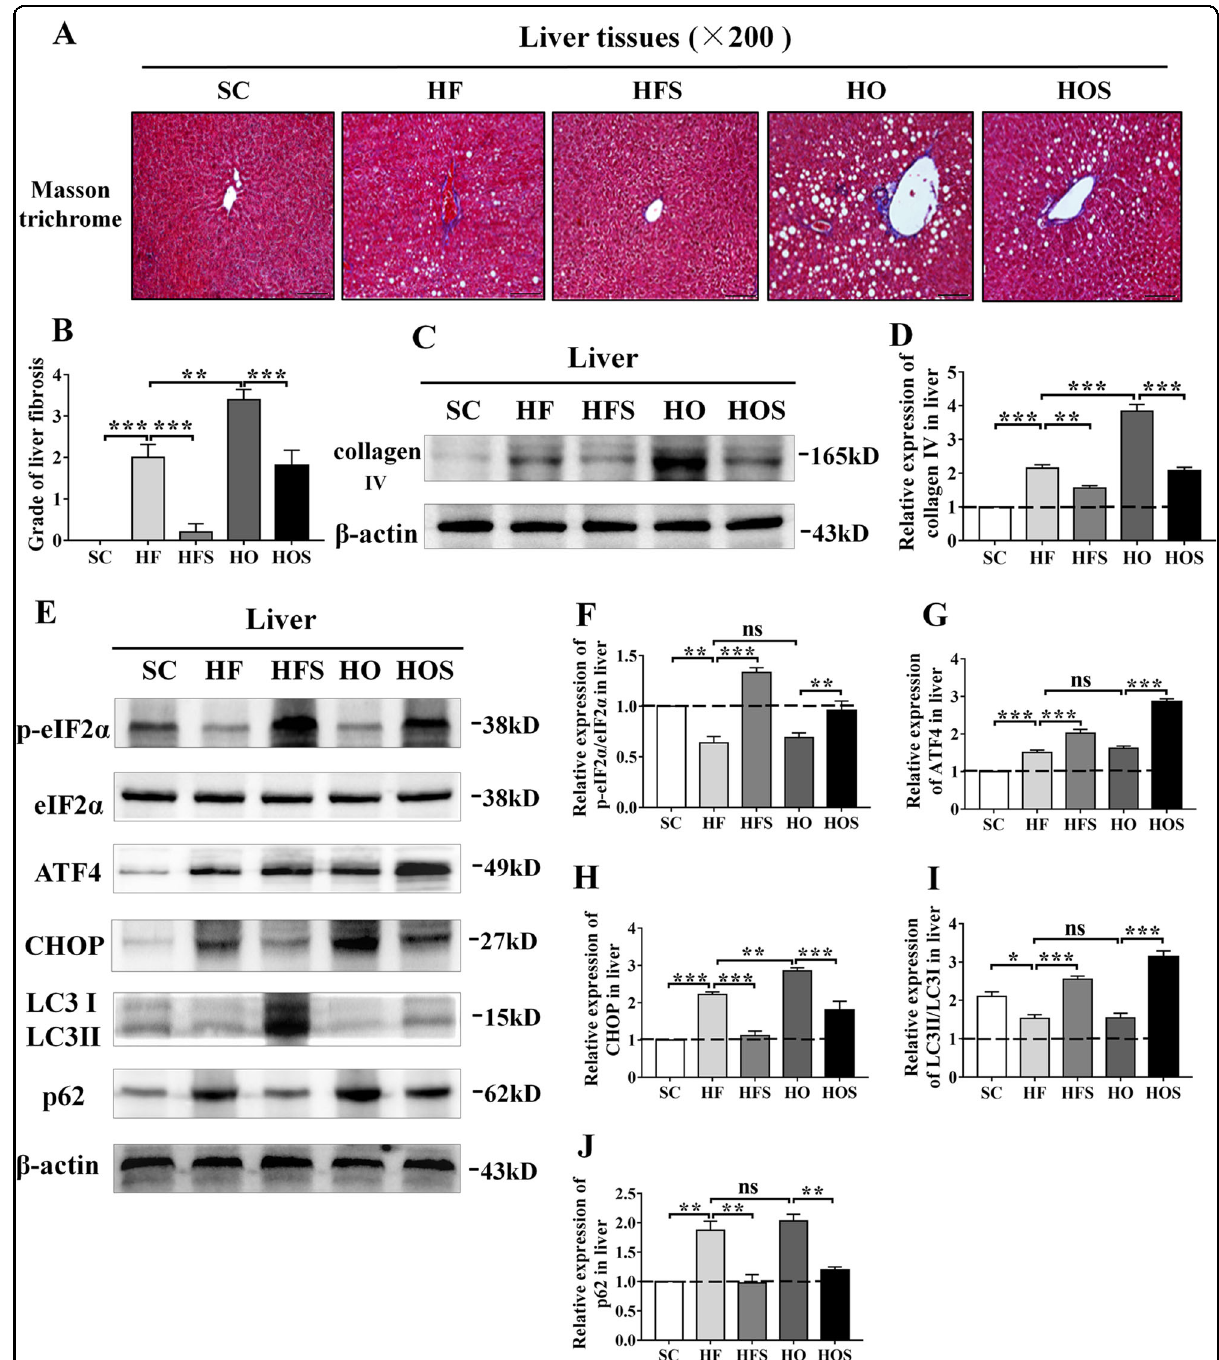
Fig. 4 Salubrinal alleviated liver fi brosis and altered the ER stress and autophagy in vivo. a Representative Masson-trichrome staining images showing salubrinal effect in liver fi brosis (200×; scale bar = 100 μ m; all graphics were in a blinded fashion). b Grade of liver fi brosis. c Representative images of Western blot for collagen IV. d Relative intensity of collagen IV. e Representative images of Western blot in the fi ve groups for selected genes involved in ER stress (p-eIF2 α , ATF4, and CHOP) and autophagy (LC3 and p62). f – j Relative intensity of p-eIF2 α /eIF2 α ( f ), ATF4 ( g ), CHOP ( h ), LC3II/I ( i ), p62 ( j ). The experiments were conducted in triplicate. The asterisks (*, **, and ***) represent P < 0.05, P < 0.01, and P < 0.001, respectively. N.s., not signi fi